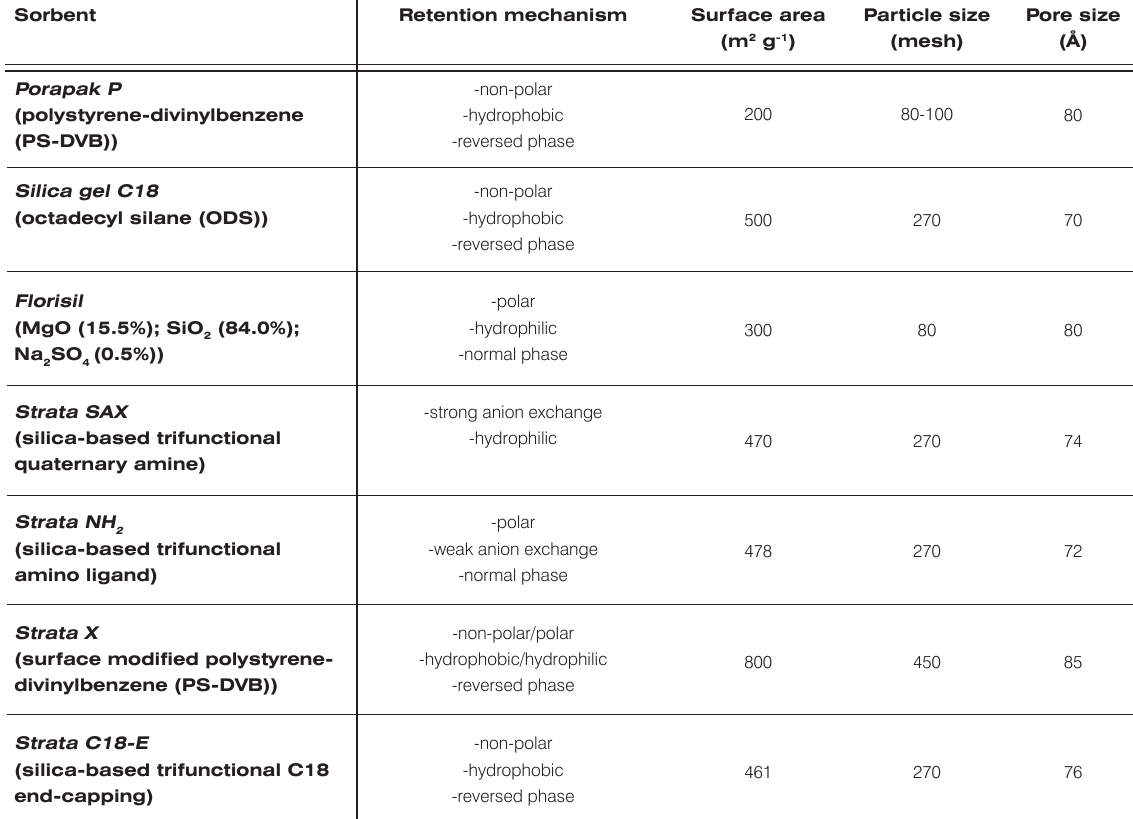
Table 1. The properties of the used